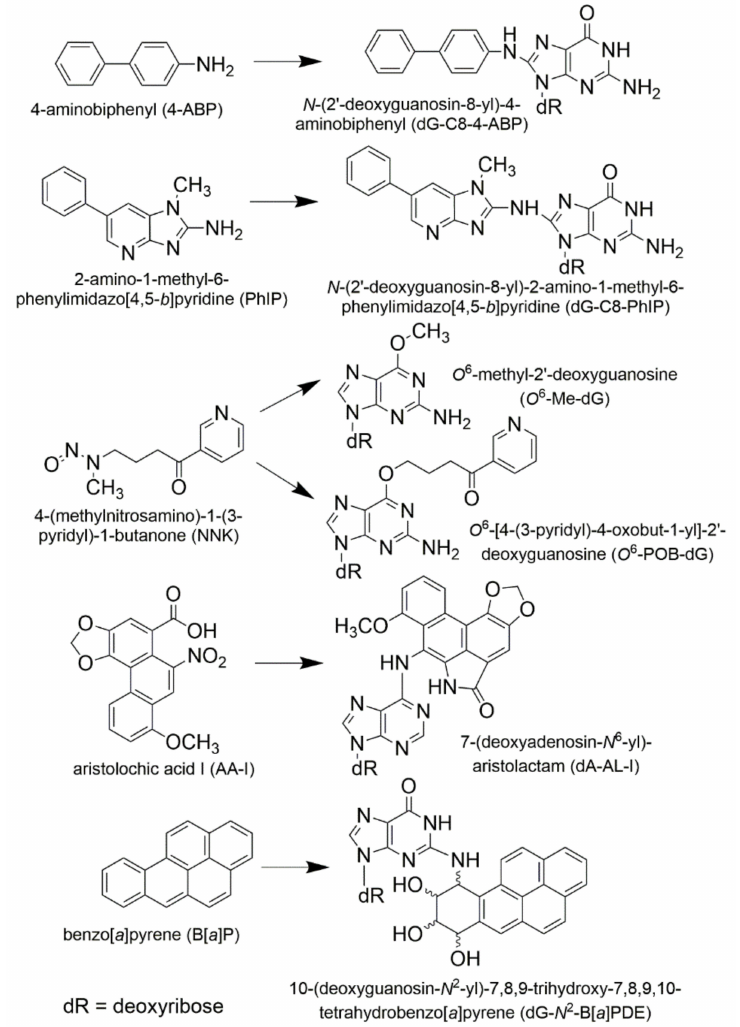
Figure 5. Structures, names, and abbreviations of carcinogens and their adducts used for quantitation of multiclass carcinogenic DNA adducts in freshly frozen and FFPE tissues of rodents. Reproduced with permission from [105]. Copyright ACS,